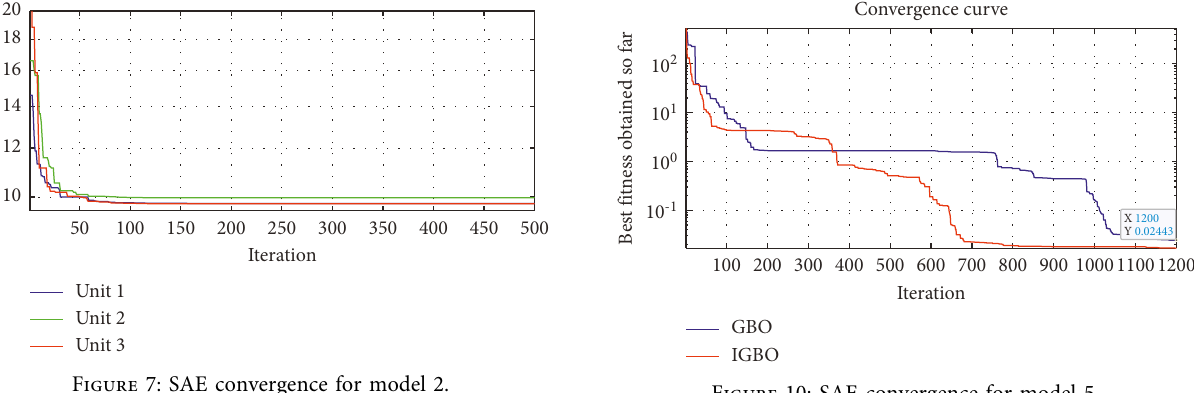
Figure 10: SAE convergence for model 5.